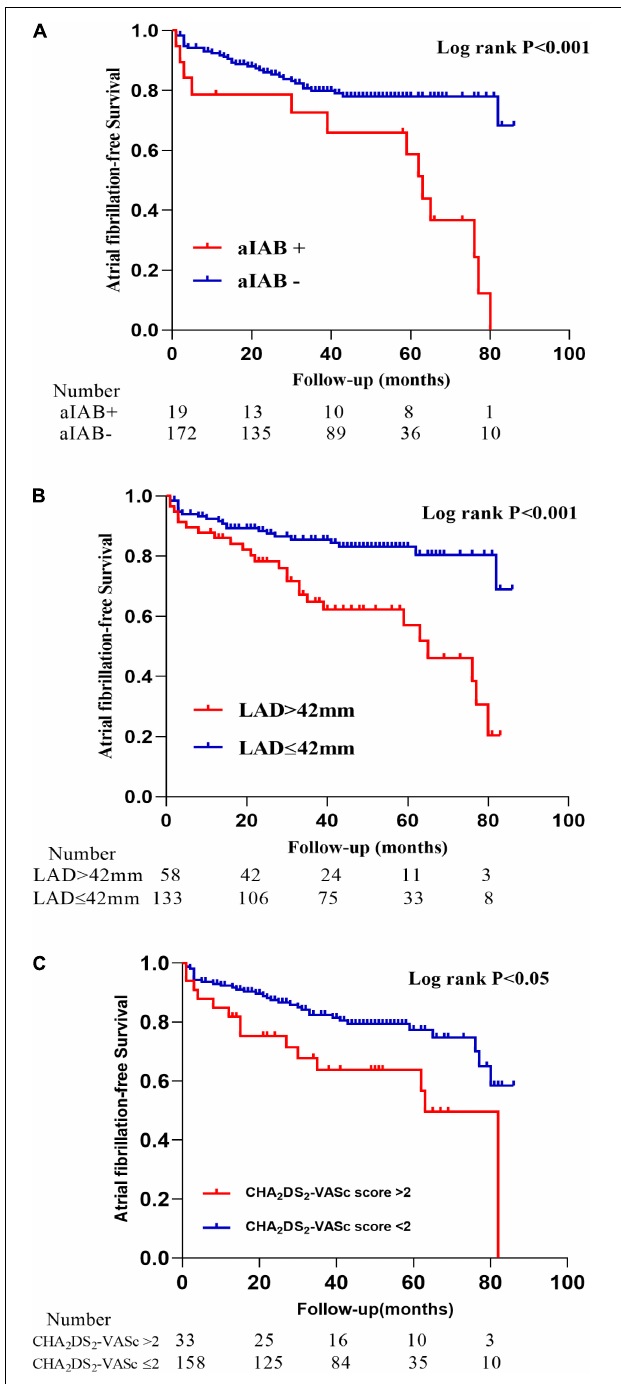
FIGURE 5 | Kaplan–Meier curves of atrial fibrillation-free survival in patients grouped by advanced interatrial block (A) , left atrial diameter (B) , and CHA 2 DS 2 -VASc score (C)